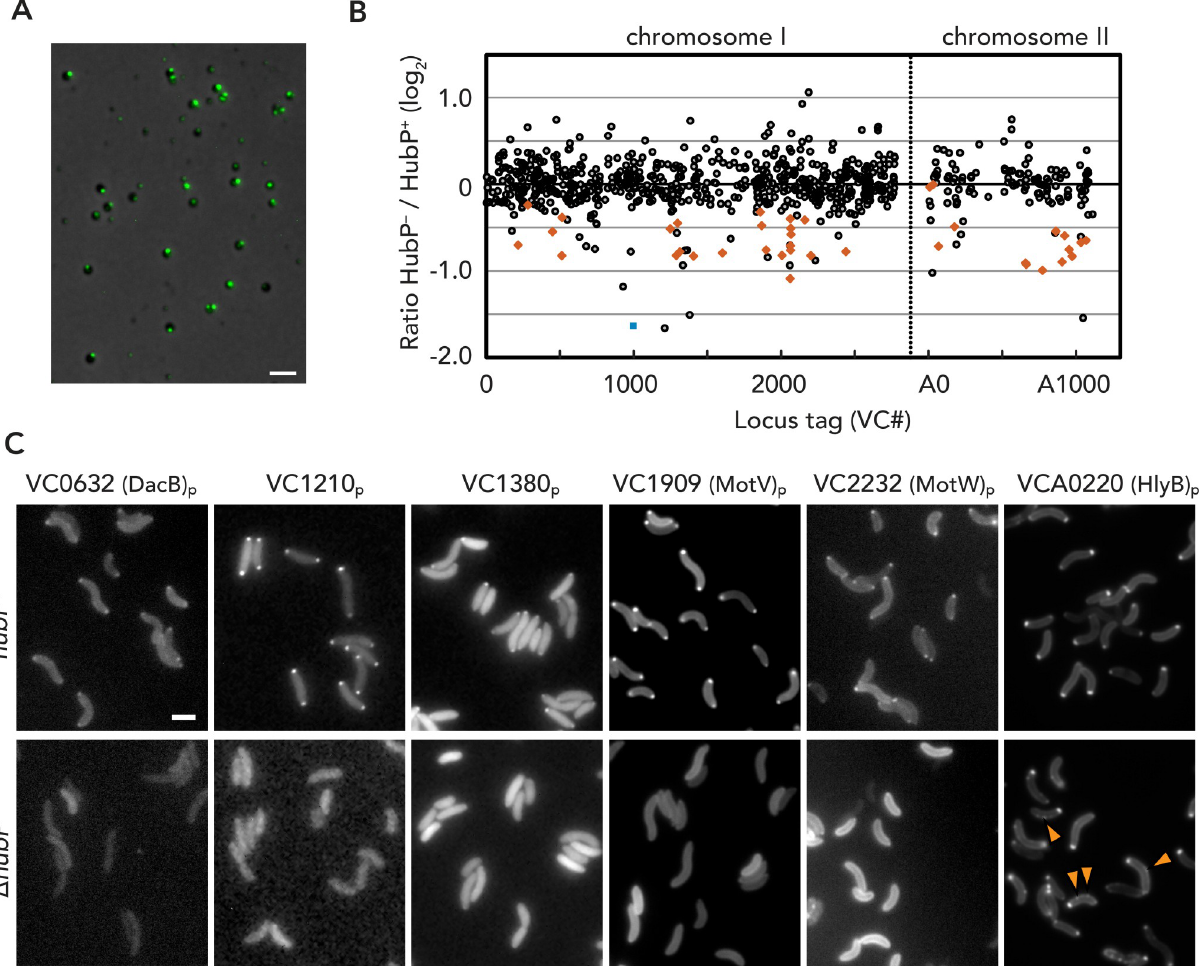
Fig 1. Comparative proteomics of minicells in search of polar proteins. (A) Representative fluorescent microscopy image of minicells purified from YBB2143 ( Δ minD Δ parA1 hubP :: hubP-yfp ). YFP signals are pseudocolored in green and merged with the corresponding phase contrast image. (B) Summary plot of iTRAQ results. Horizontal axis: proteins’ locus tag on each chromosome; Y-axis, log2 of HubP - /HubP + value from two independent experiments. A blue square indicates HubP (VC0998); known proteins related to chemotaxis are indicated by orange diamonds. (C) Representative fluorescence microscopy images of C-terminal GFP fusions of indicated candidate proteins in hubP + and Δ hubP V . cholerae cells. Bars = 2 μ